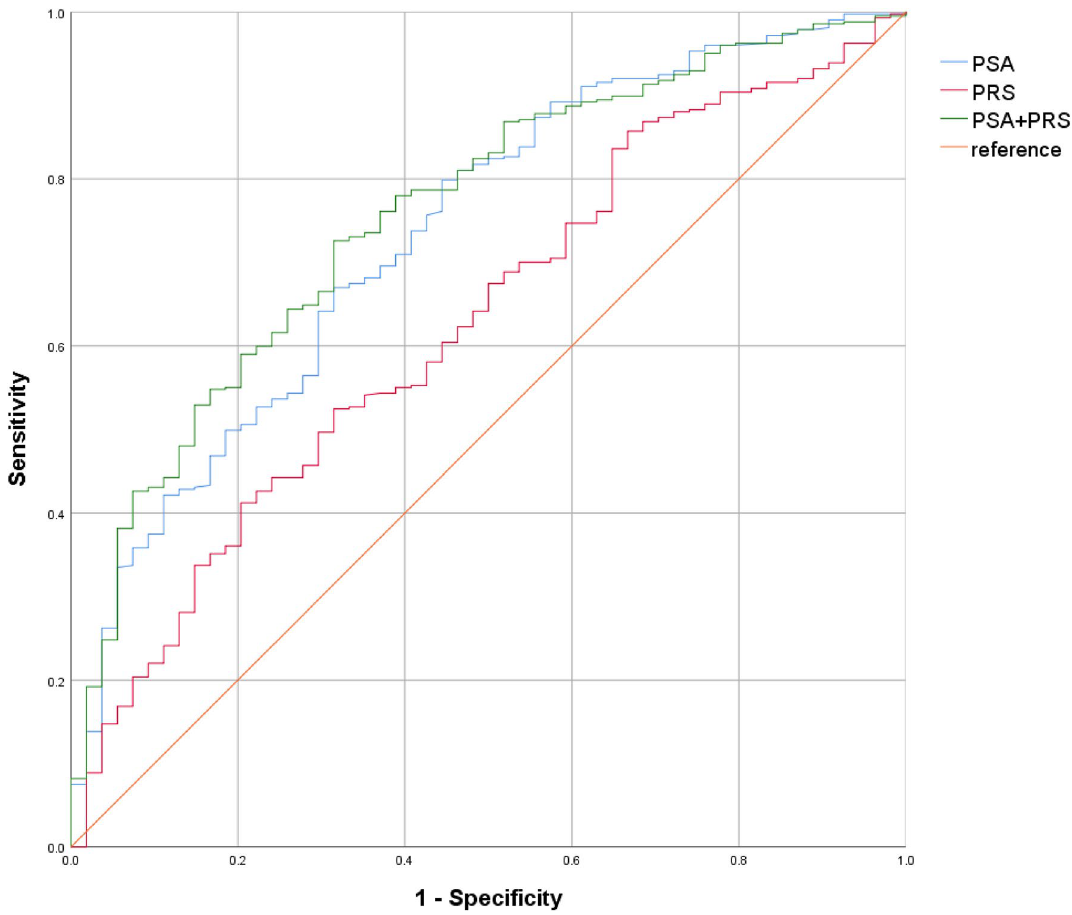
Figure 2. AUROC of PSA, PRS, and combined PSA + PRS model in early onset csPCa (≥ GG2 in age <